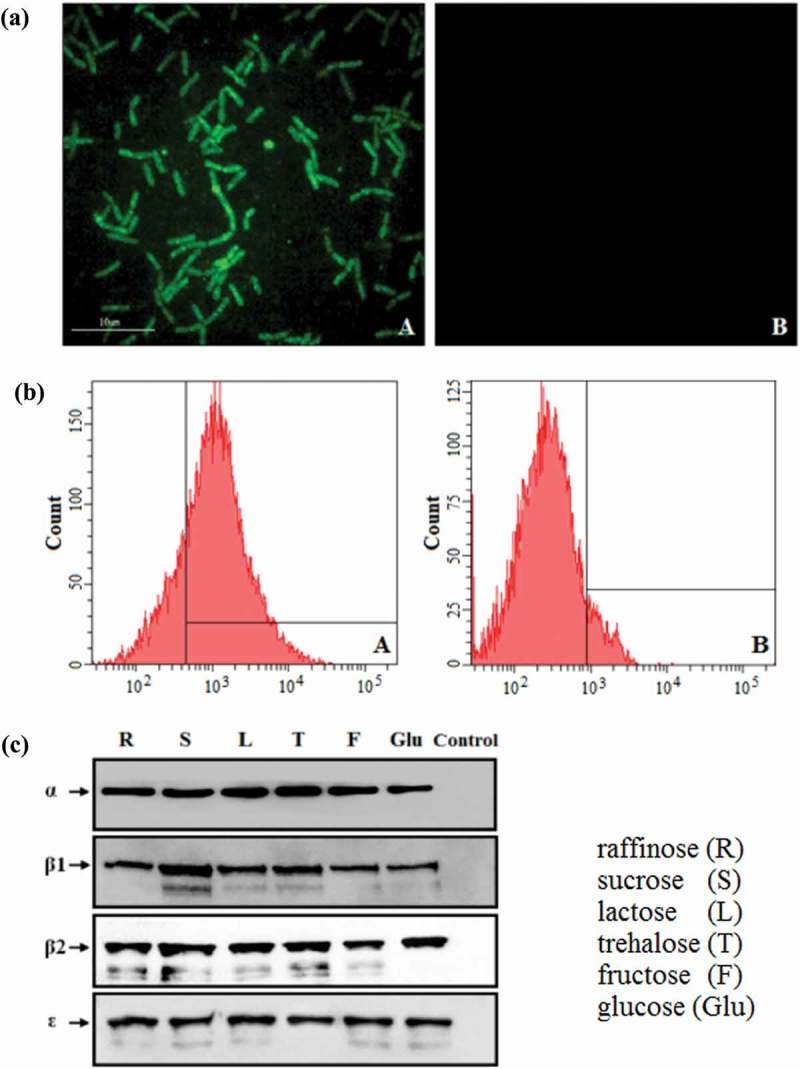
Constitutive expression of proteins. (a) The pPG-Δ-E-α-β2-ϵ-β1/L. casei 393 cultured in normal MRS broth was analyzed by ultra-high-resolution microscopy, and results showed that significant green fluorescence was observed (Figure 2(a): A), but not in the pPG-T7g10-PPT/L. casei 393 strain (Figure 2(a): B). (b) Flow cytometry results showed that EGFP was effectively expressed by pPG-Δ-E-α-β2-ϵ-β1/L. casei 393 (Figure 2(b): A). (c) Western blot results showed that the α-β2-ϵ-β1 fusion protein can be constitutively expressed by the pPG-Δ-E-α-β2-ϵ-β1/L. casei 393 strain using raffinose (R), sucrose (S), lactose (L), trehalose (T), glucose (Glu), and fructose (F) as carbon sources, respectively.